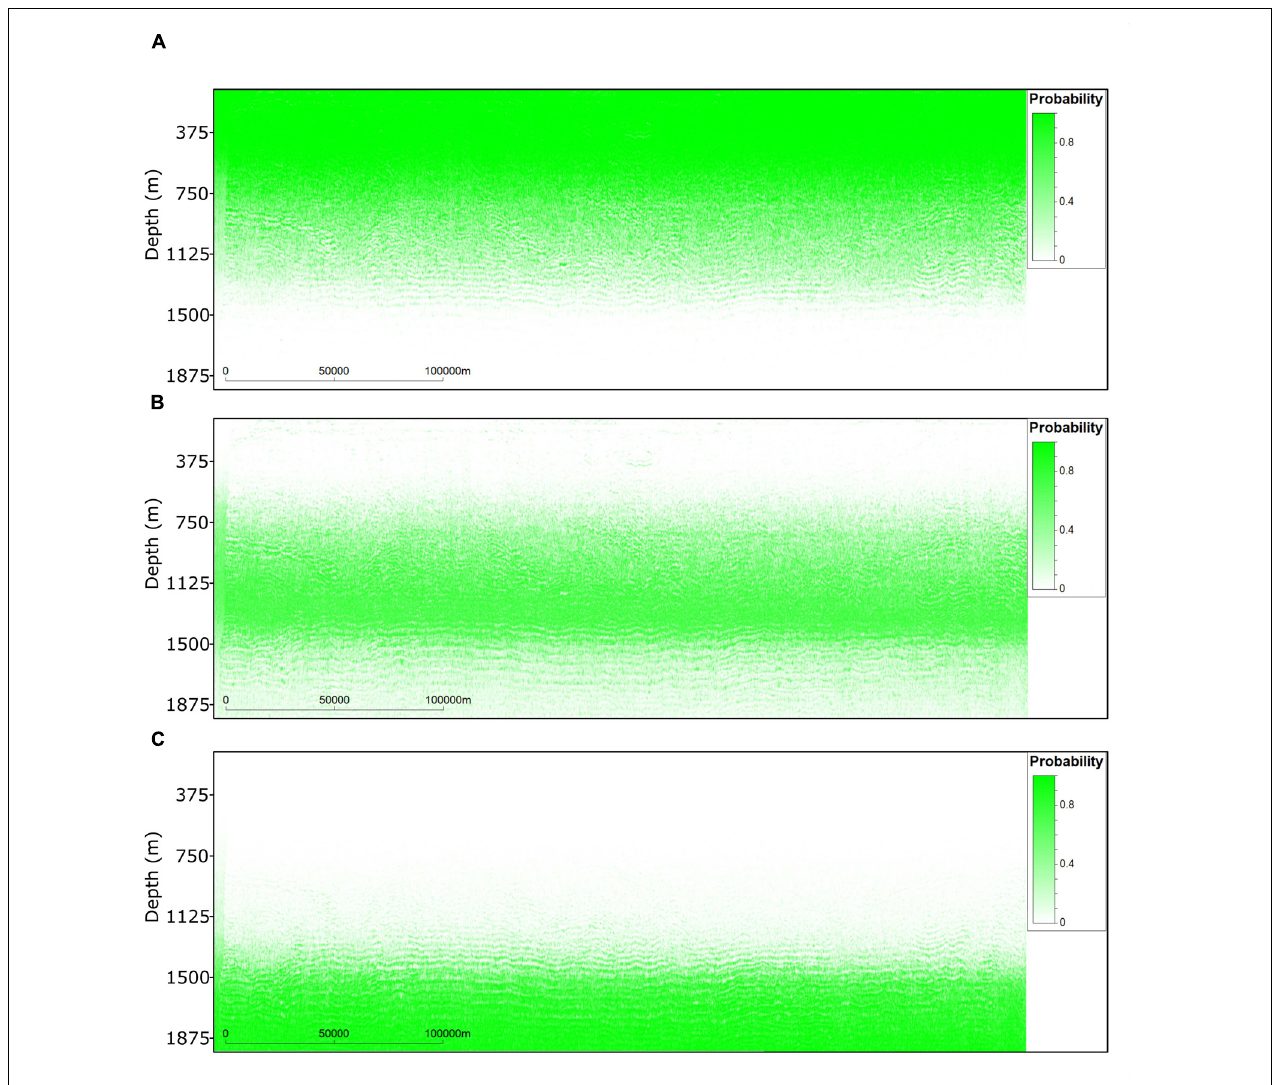
FIGURE 15 | Probability of occurrence of: (A) Central Atlantic Water; (B) Mediterranean Outflow Water; (C) Subarctic Intermediate Water. Probability models calculated from the classification of the thirty-two temperature and salinity models generated during the last iteration of the inversion using the training data shown in Figure 5